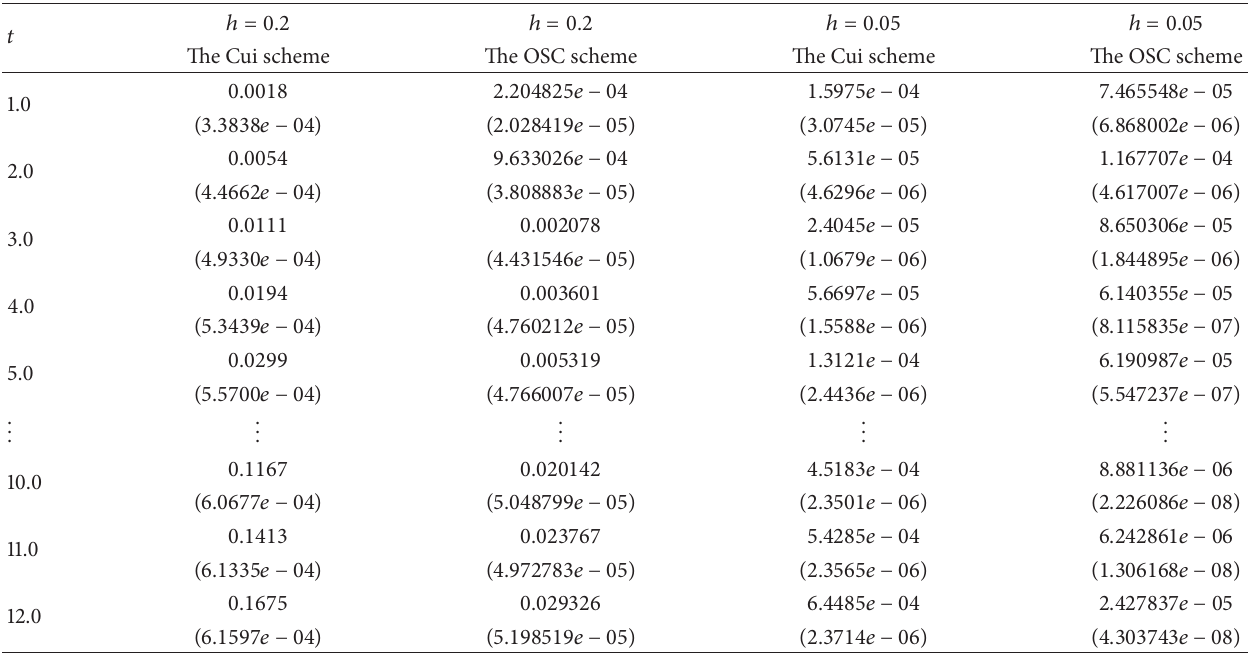
Table 2: Relative errors comparison of the Cui scheme and the OSC scheme for Example 1 with 𝜏 = 0.01